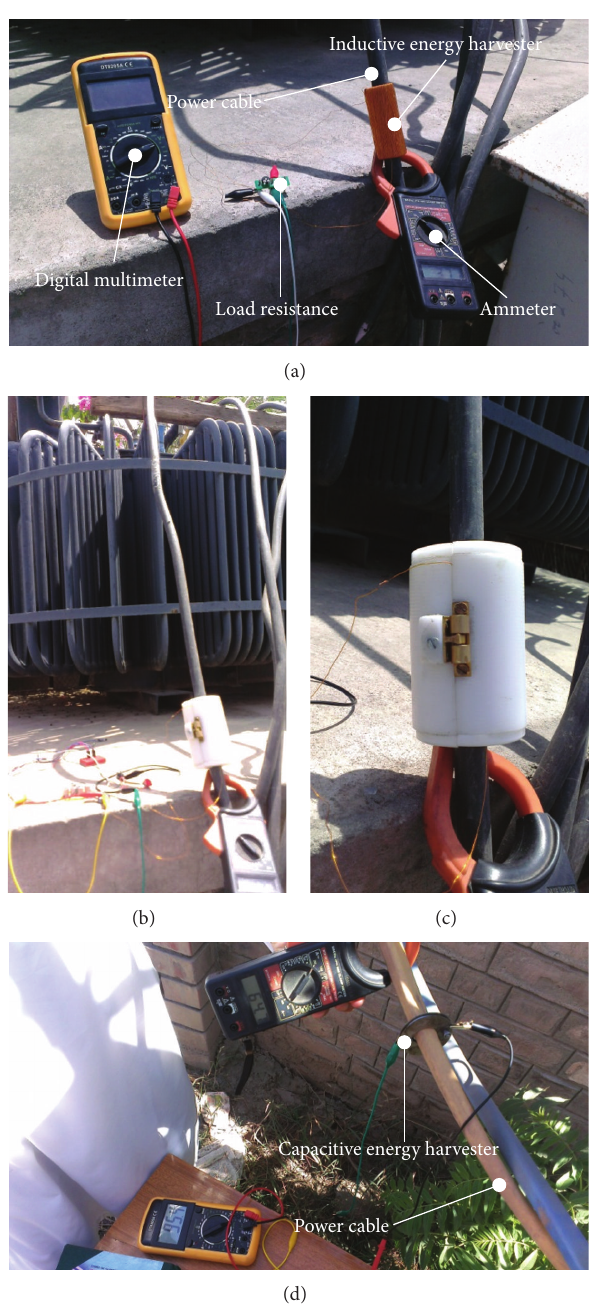
Figure 15: Characterization of developed prototypes: (a) load voltage measurement of inductive energy harvester, (b) inductive energy harvester enclosed inside Teflon housing, (c) close-up view of inductive energy harvester during experimentation, and (d) measurement of voltage from the capacitive harvesting